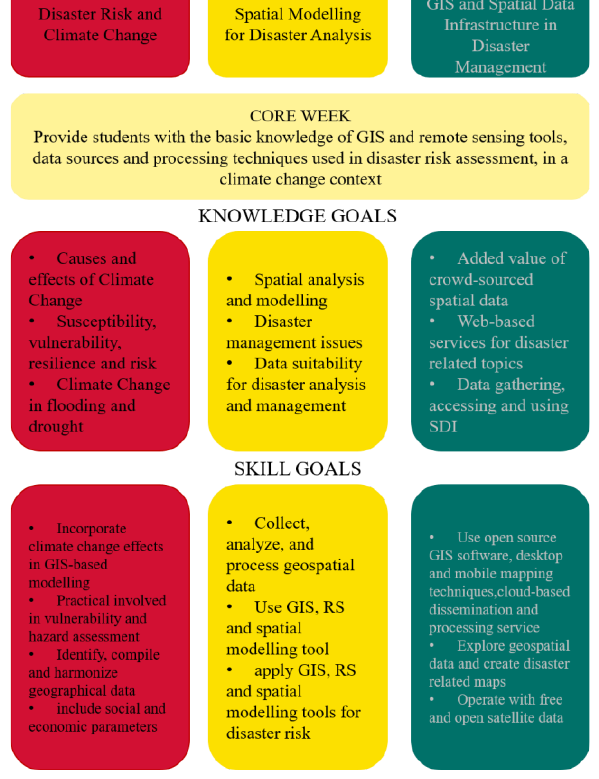
Figure 1. Knowledge body of the three